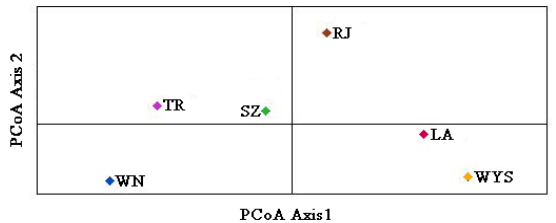
Figure 2. The principal coordinate analysis (PCoA) plot of six populations of C. tsoongiana based on the two principal axes (first axis = 43.94%, second axis = 21.14%).